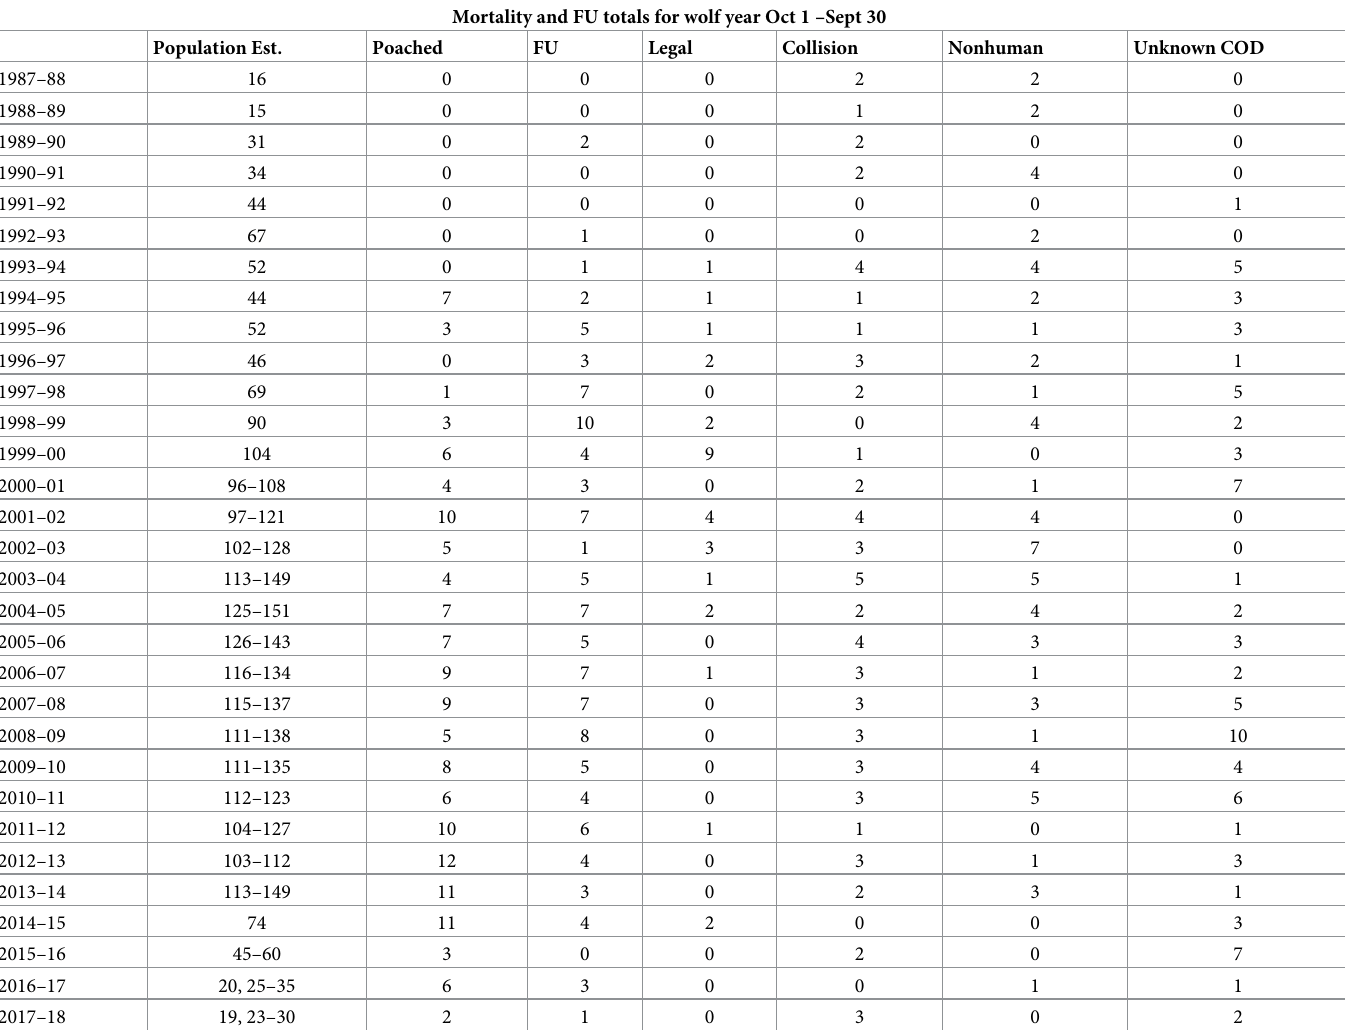
Table 1. Annual red wolf population size, COD and FU for collared, adult red